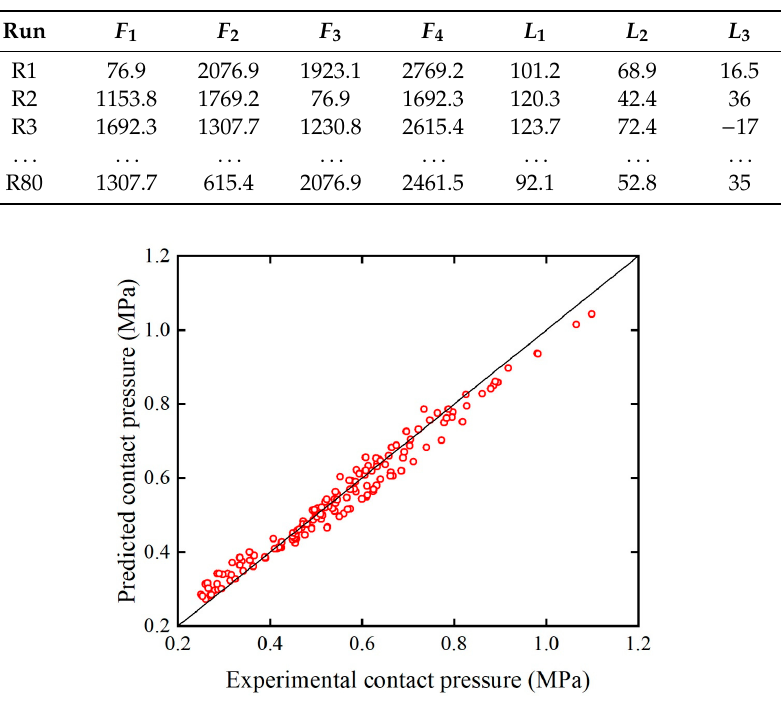
Figure 10. Predictions of the contact pressure of the agent model and the FE model.